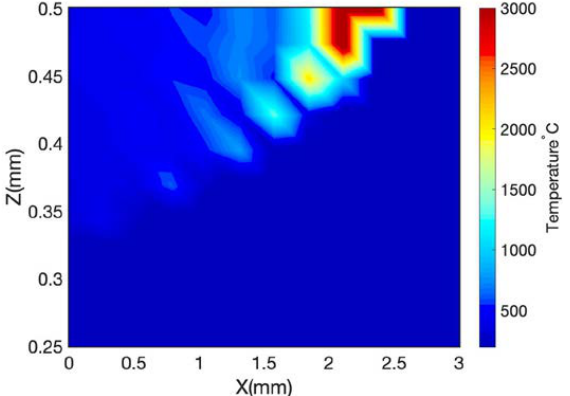
Figure 4. Predicted temperature field for the fabricated IN718 sample built via L-PBF with the laser power of 150 W, scan speed of 600 mm / s, layer thickness of 30 µ m, and hatching space of 100 µ